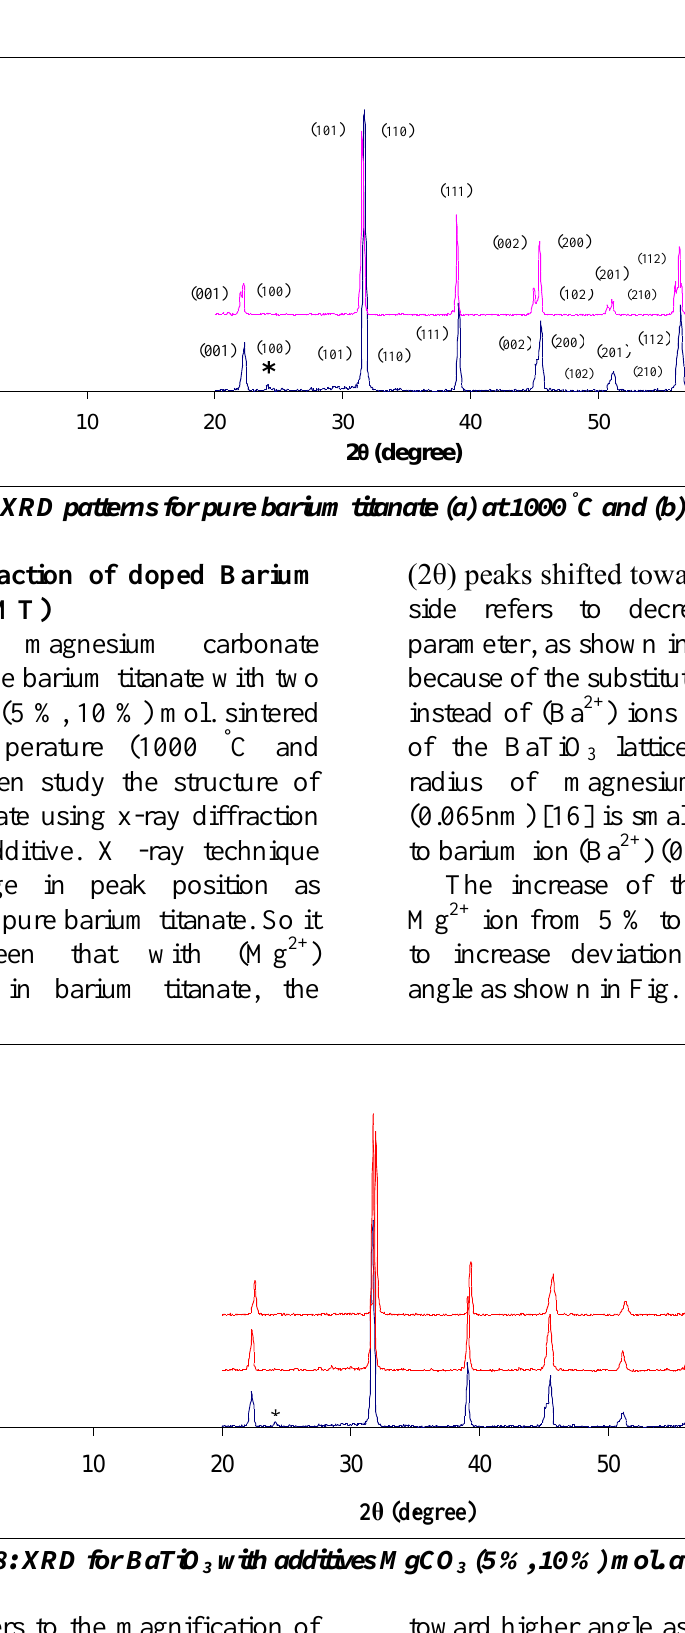
with additives MgCO 3